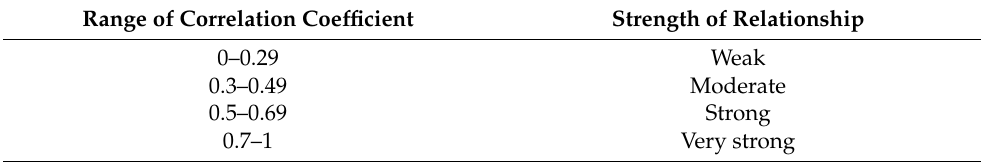
Table 7. Interpretation of the correlation coefficients.